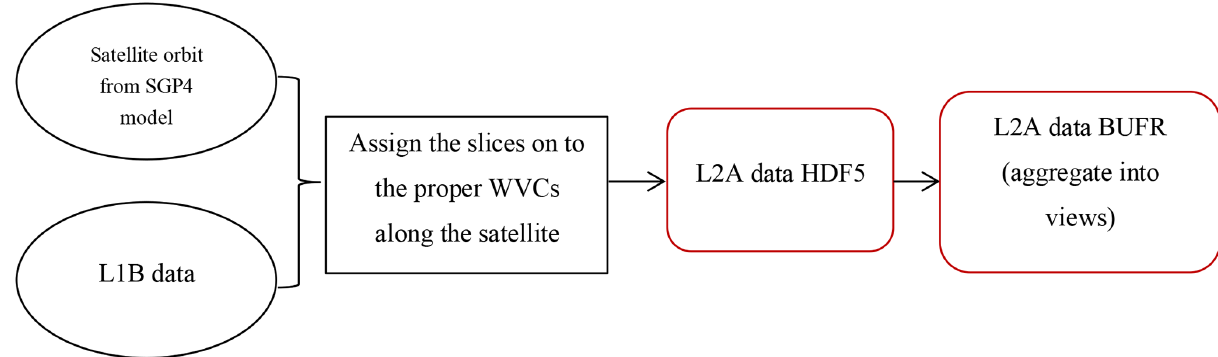
Figure 7. The workflow to assign L1B data to the proper WVCs and aggregate into views.